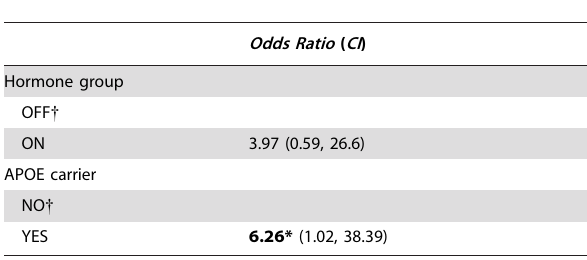
Table 2. Odds ratios and 95% CI for predictors of telomere shortening.